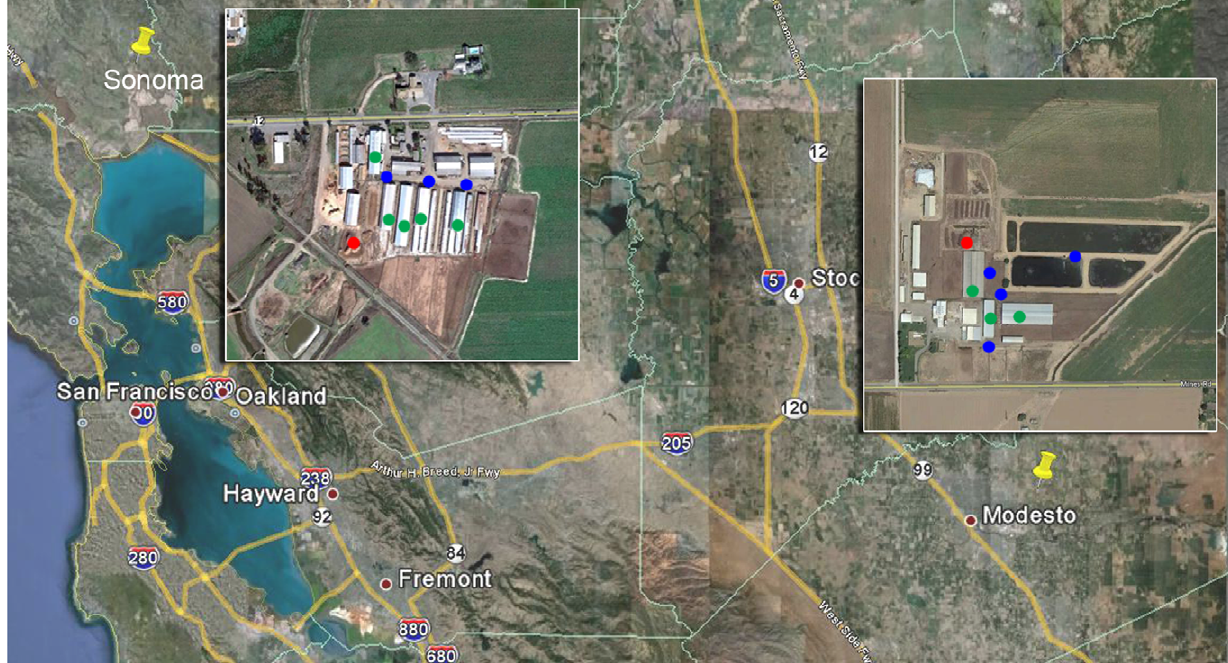
Figure 1. Google map showing the locations of dairies in California and the sampling locations. Blue dots are aerosol sampling locations. Green dots represent the stalls from where fresh manure was collected. Red dots are on-site locations for dry manure. The same color coding is used in Figures 2, 3 and 5 to designate the sample sources for the bacterial taxa.